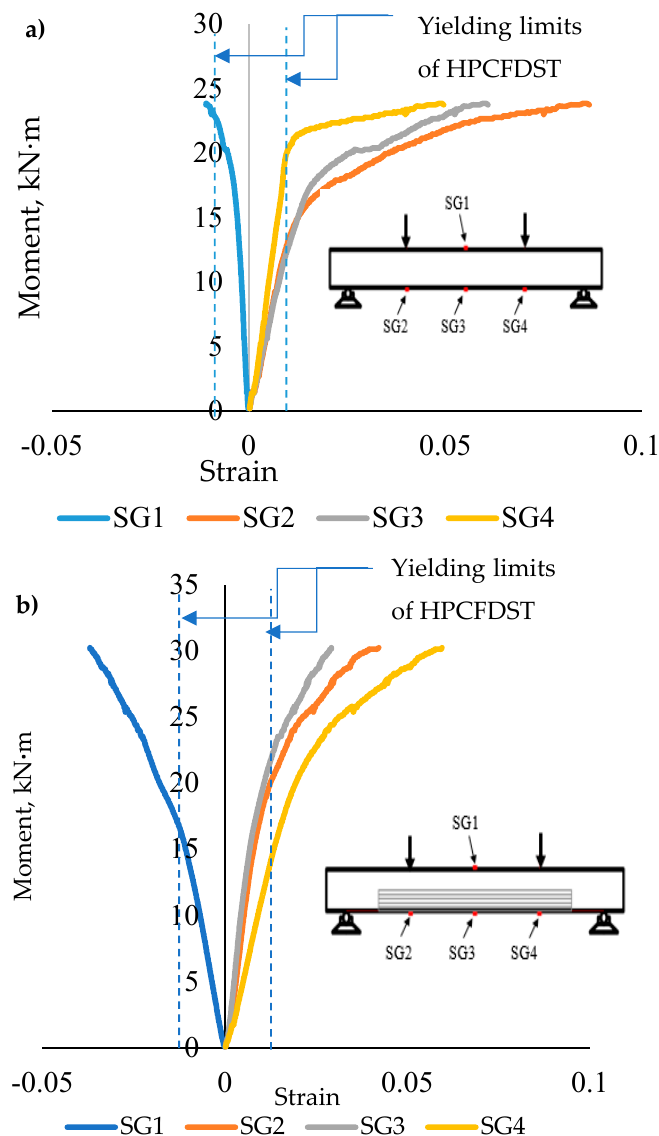
Figure 9. Relationship between moment and strain for ( a ) B–C and ( b ) B-P75-2L specimens.